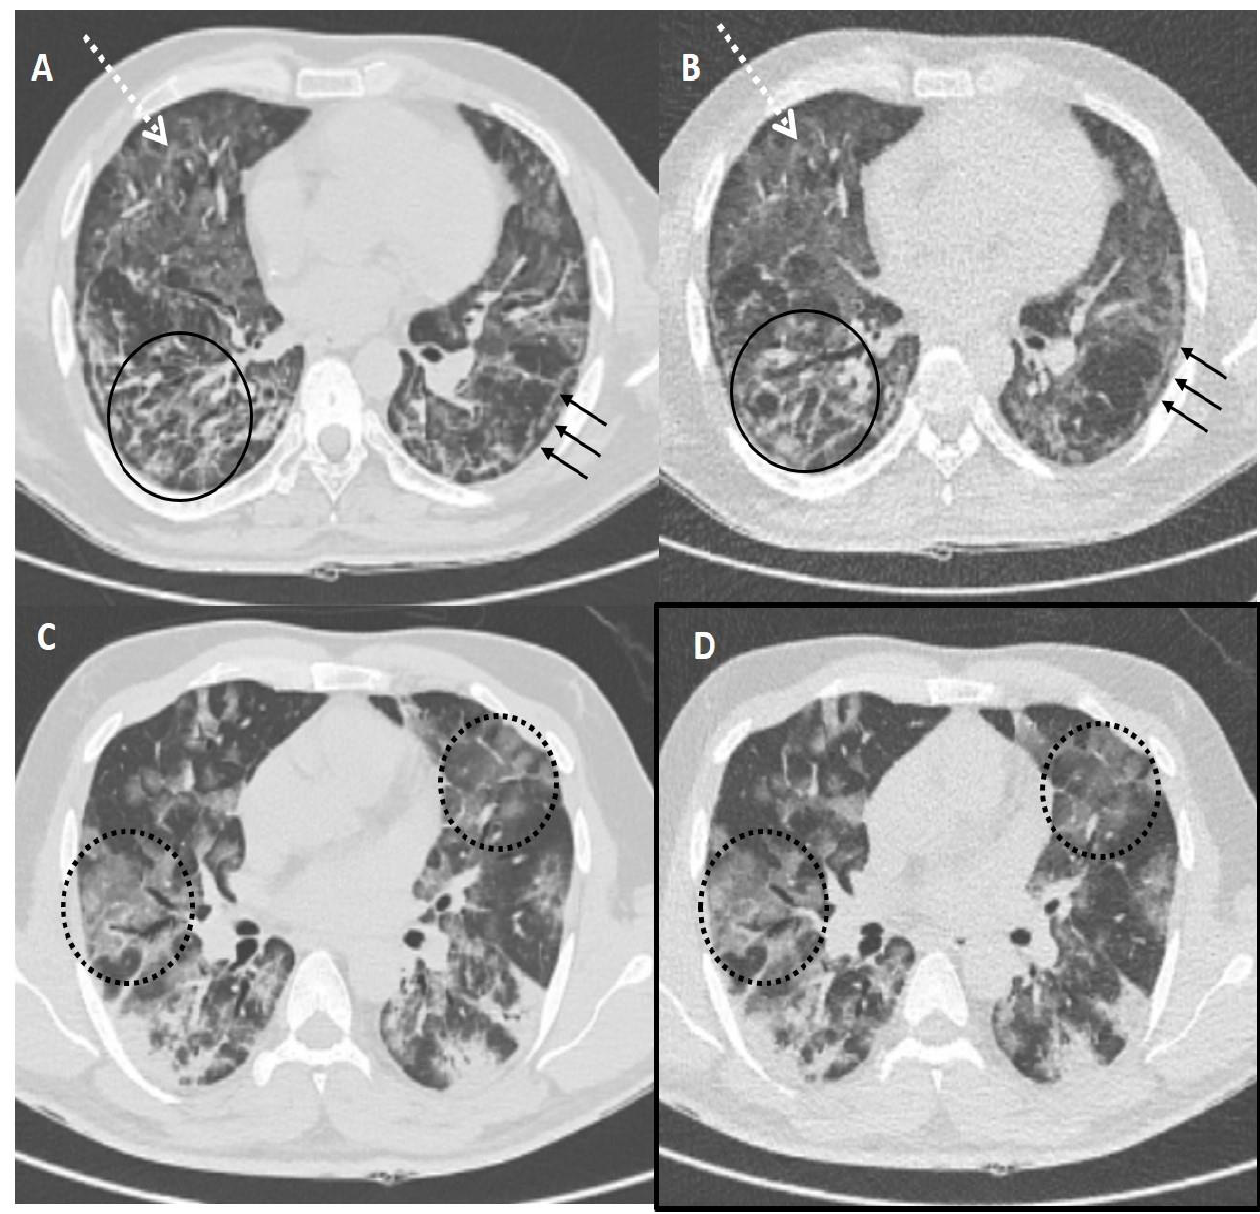
Figure 4. Comparison of standard-dose CT (SDCT) chest and ultra-low dose CT (ULDCT) chest in two different COVID-19 patients: ( A , B ) A 51-years old male with SDCT ( A ) and corresponding ULDCT ( B ) images showing interlobular septal thickening/reticulation (black circles) and parenchymal bands (black arrows), with interspersed areas of GGOs in both lungs (dotted white arrows). ( C , D ) A 45-years old male patient with SDCT chest ( C ) and corresponding ULDCT chest ( D ) showing areas of GGOs with interlobular septal thickening giving a crazy-paving pattern (dotted circles). The CT severity score calculated on SDCT and ULDCT was found to be similar in both patients, while the effective radiation dose for SDCT was 4.63 mSv and 4.81 mSv, and for ULDCT was 0.26 mSv and 0.28 mSv, respectively.